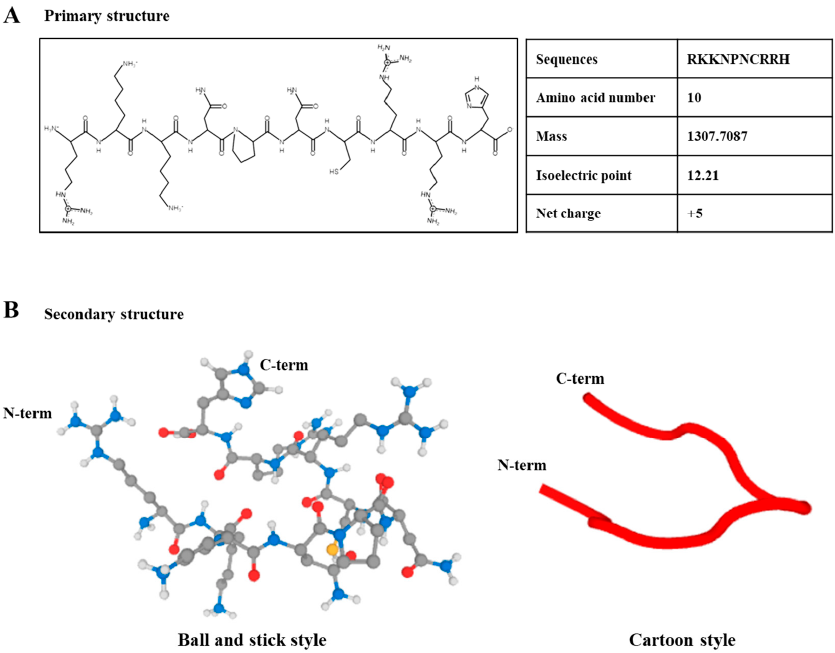
Figure 1. Structural illustration of heparin-binding peptide (HBP). ( A ) Primary structure of synthetic HBP composed of 10 amino acids and ( B ) secondary structure, presented as ball-and-stick and cartoon styles (Black; carbon, Blue; nitrogen, Red; Oxygen, Yellow; Sulfur; White;